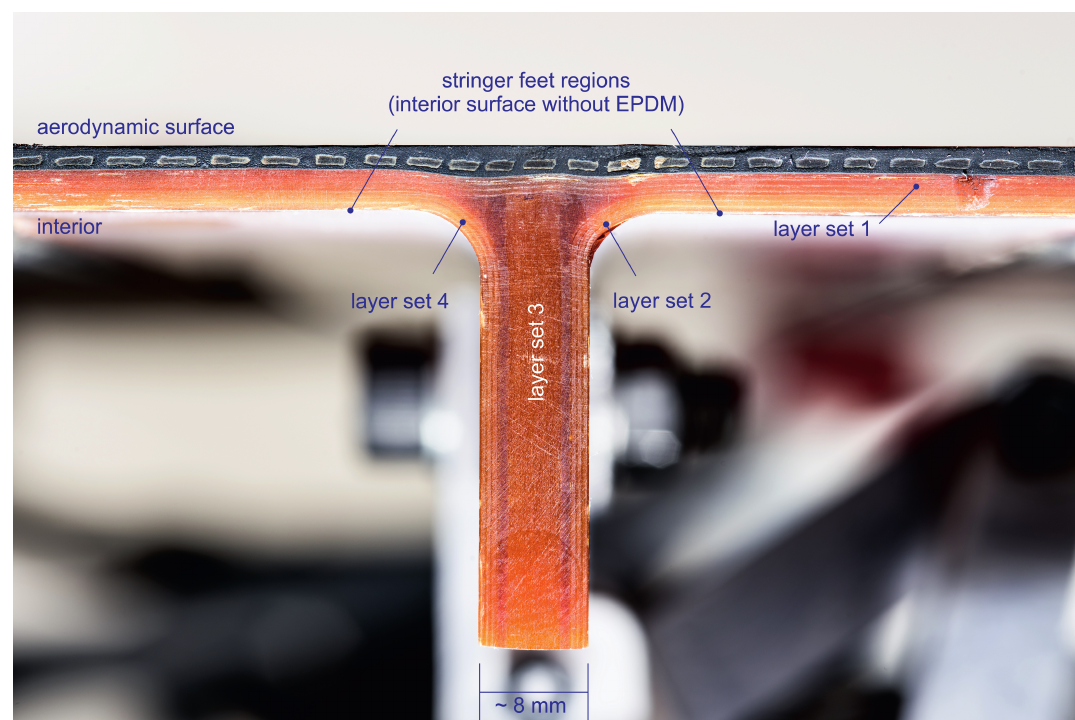
Figure 13. Labelled cross-section-detail photograph of the manufactured integral stringer.